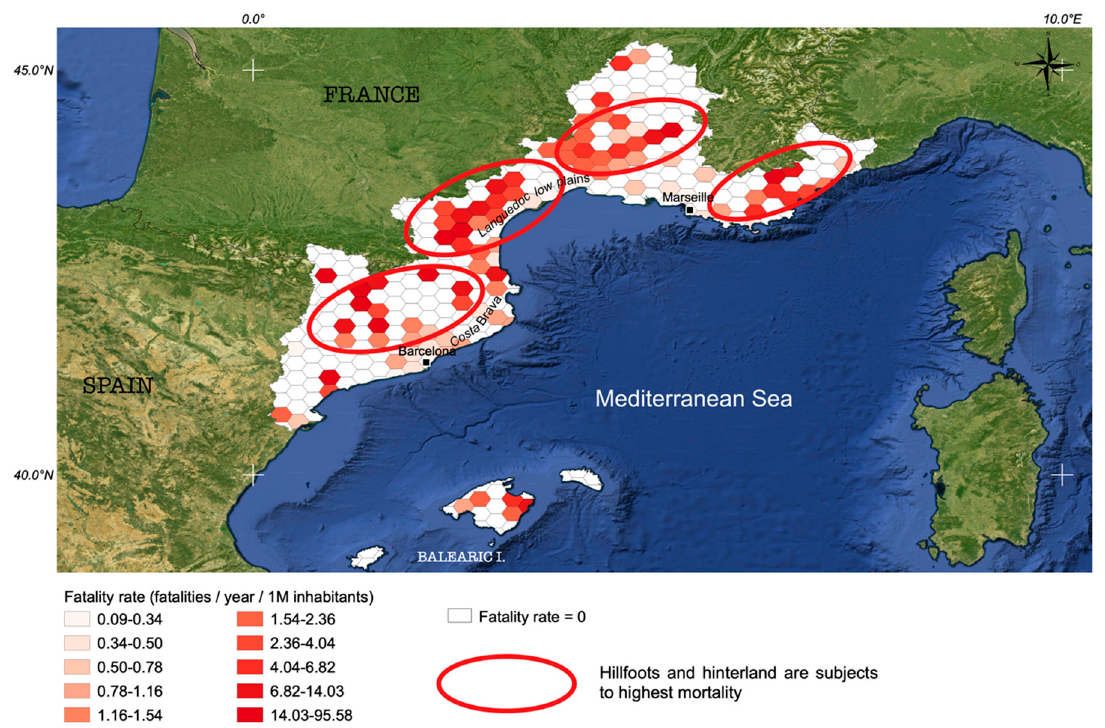
Figure 8. A focus on the western Mediterranean Basin (Catalonia, Southern France, and Balearic Islands) with a hex 20 × 20 km grid, based on the decile classification excluding 0.00 values.